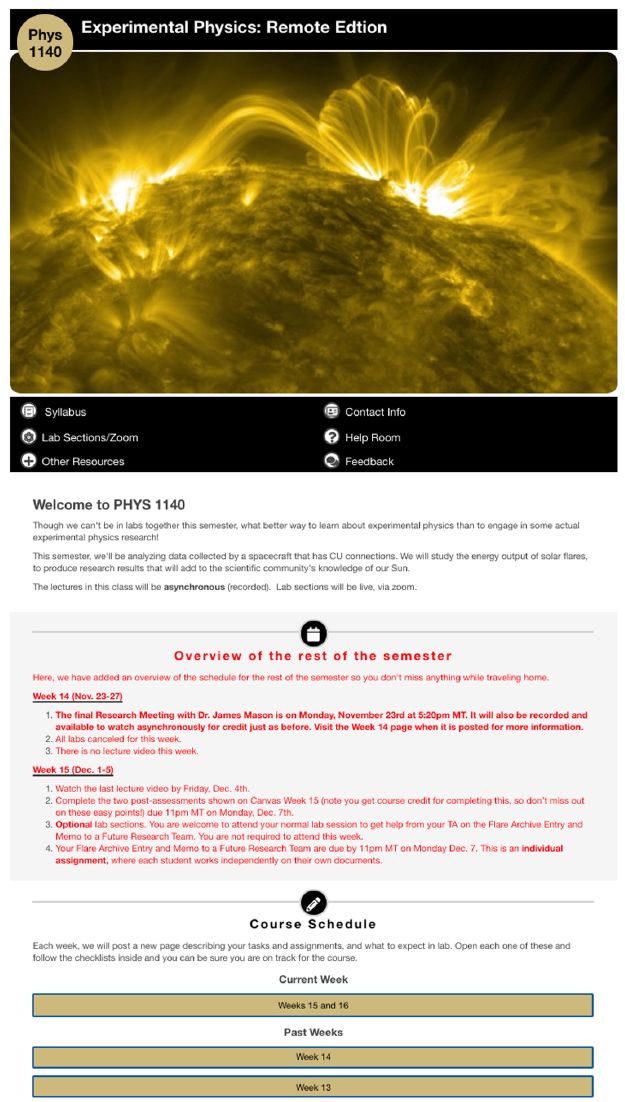
FIG. 1. The front page of our course page on Canvas had clear links to the Zoom meetings and help sessions at the top, important information highlighted in red, and buttons for the pages detailing the activities and assignments for each week on the